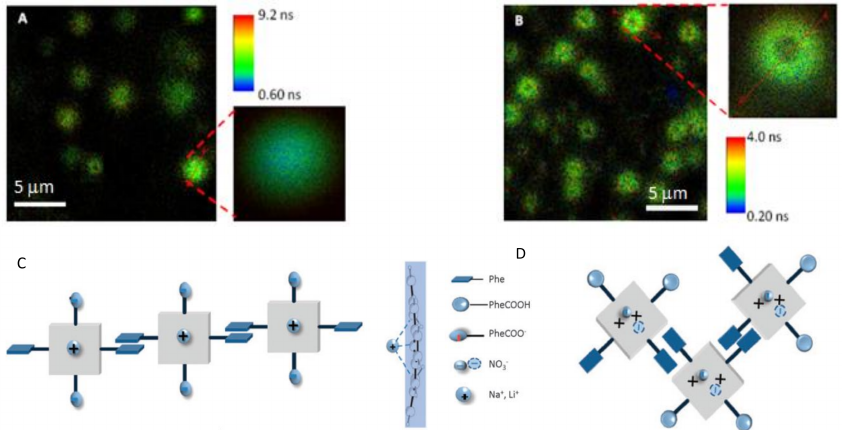
Figure 3. Representative FLIM images and amplifications of marked regions of ( A ) DiCPP-opp at pH = 12 (NaOH) and of ( B ) DiCPP-adj at pH = 0.8 (HNO 3 ). Possible models for the aggregates’ structure: ( C ) End-to-end porphyrinic arrays in DiCPP-opp, pH = 12 (front and side views), and ( D ) layer-by-layer porphyrinic arrays in DiCPP-adj, pH = 0.8. Reproduced from [34] with permission from the Centre National de la Recherche Scientifique (CNRS) and The Royal Society of